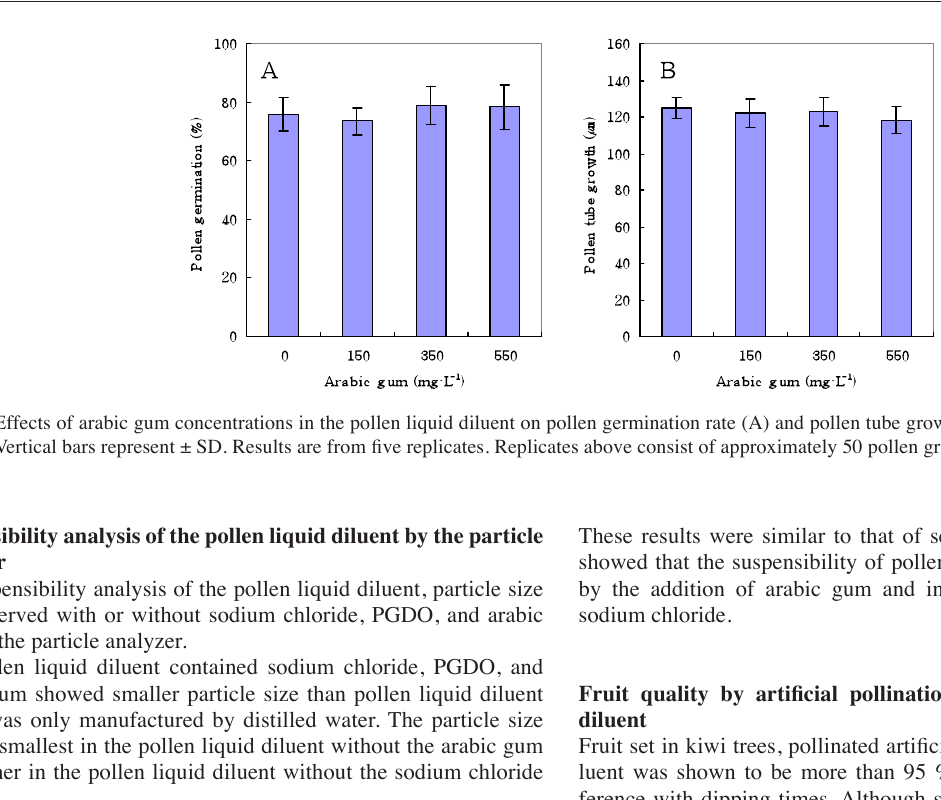
Suspensibility analysis of the pollen liquid diluent by the particle